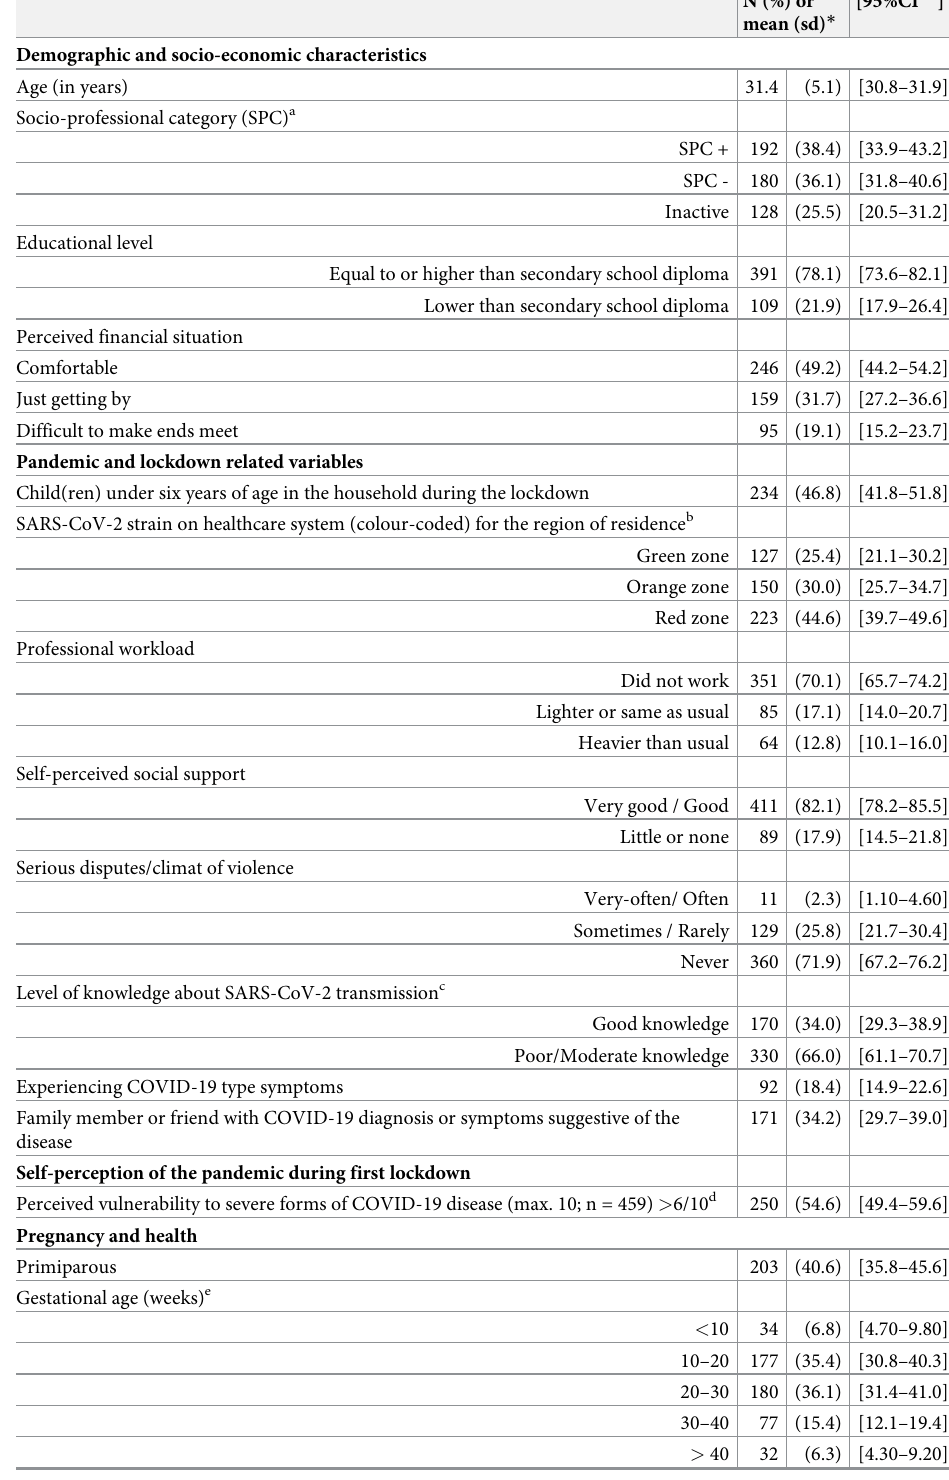
Table 1. Description of pregnant women during the first COVID-19-related lockdown (March-May 2020) who participated in the Covimater survey (n = 500), France (July